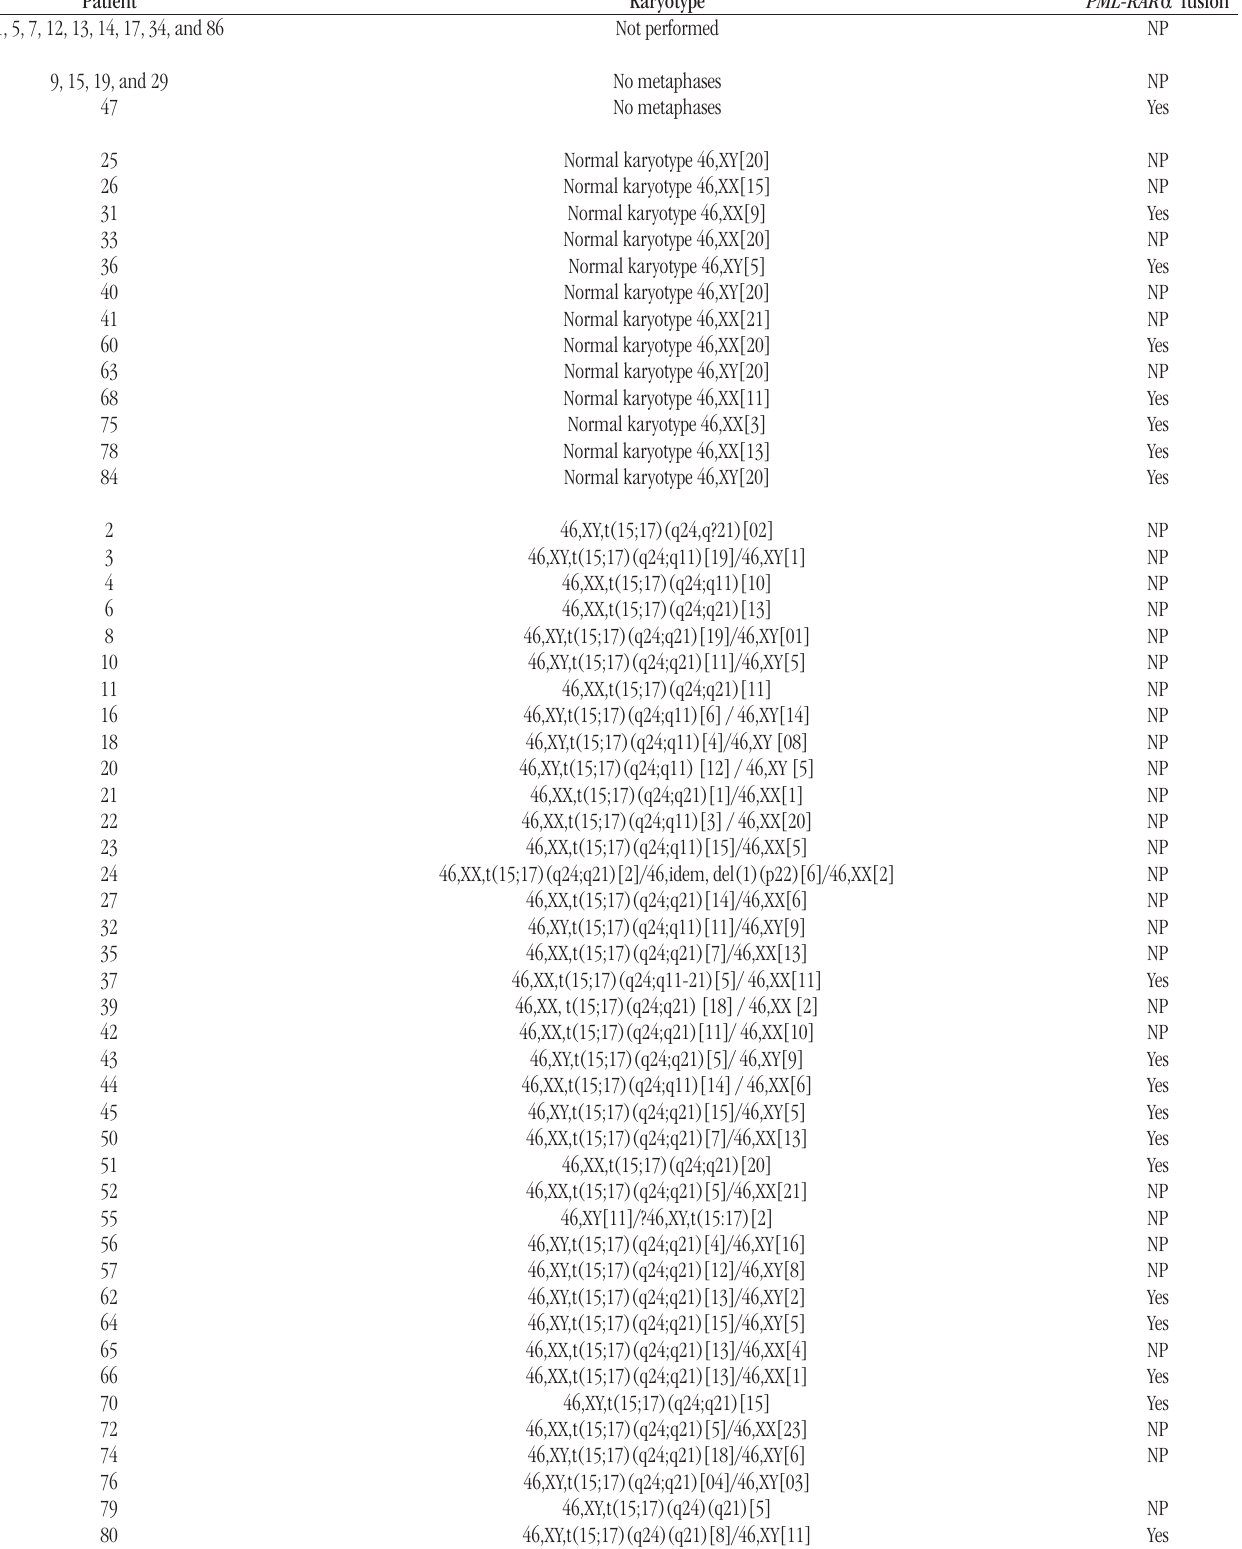
taBLE 2 – Karyotype and PML-RAR α fusion